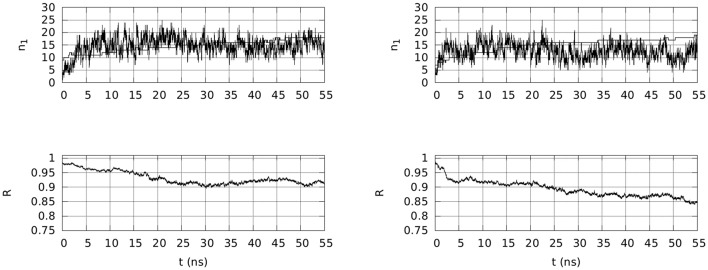
Top: Time evolution, within 55 ns of simulation, of the number of contacts (n1) involving any atom in OPN and OPN-R3, and either Na (thin line) and Mg (thick line) ions (d0 = 0.28 nm). Bottom: Time evolution, in the same time-window, of R (Equation 2 in the Supplementary Material), describing the extent of assembly between OPN and its RNA aptamer. Left panels are for trajectory 1 and right panels for trajectory 3.